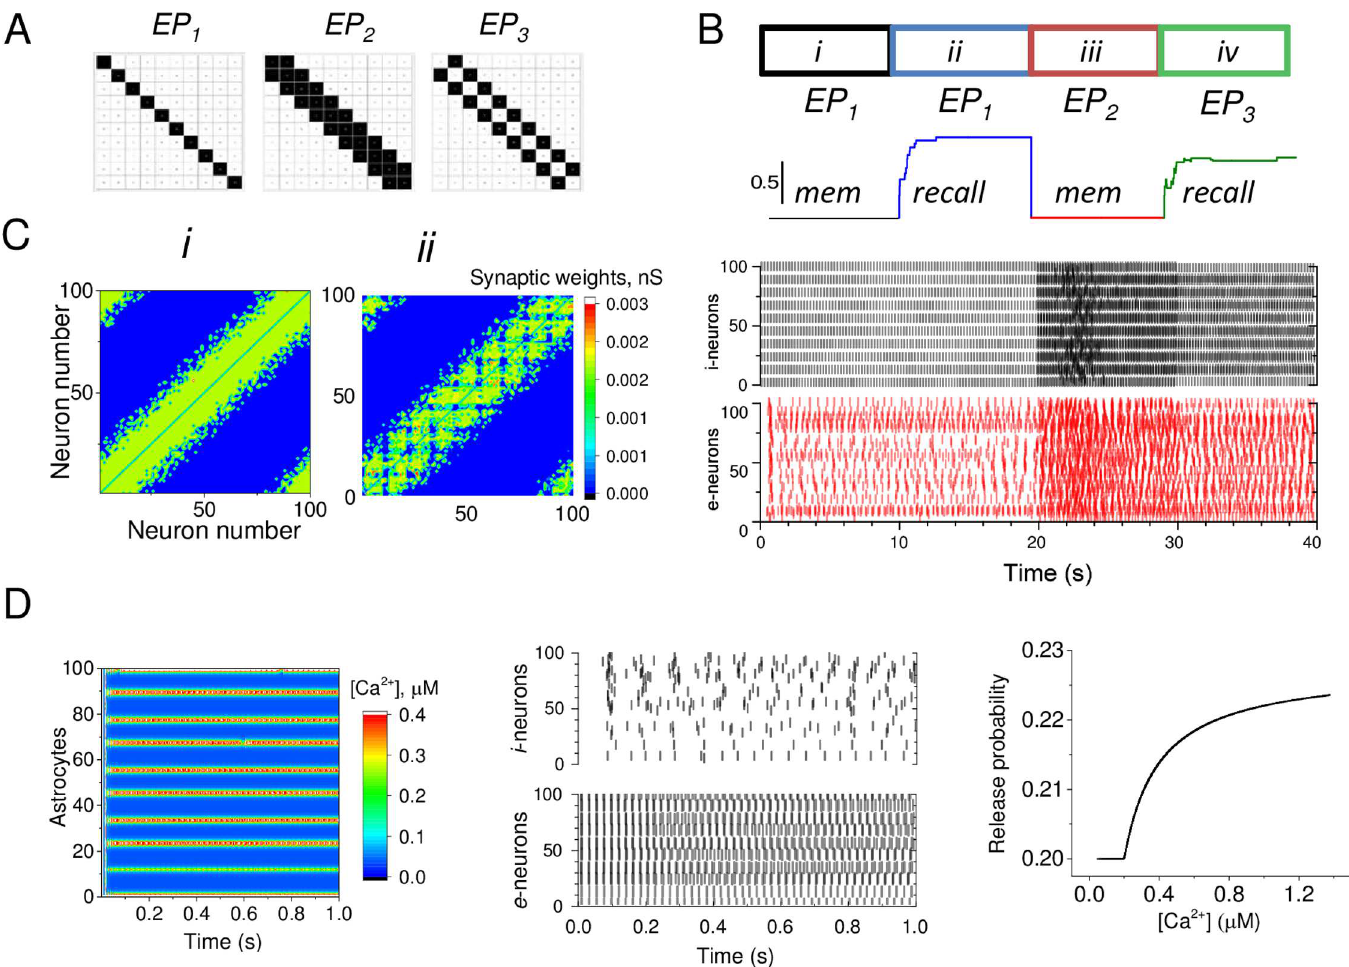
Fig 4. Exploring network memorisation, recall, and the effects of astroglial signalling. (A) External input patterns (EPs) used in simulations, as indicated. (B) Top , four successivenetwork stages ( i-iv ) of memorisation and recall, and the correspondingEPs, as indicated. Middle trace , dynamics of the recall quality(colours depict network stages). Bottom , spikingraster plots depictingthe overall dynamics of e- and i -networks correspondingto the four stages as above. (C) Exampleof the ee synapticconnections matrixes corresponding to the end of stages i and ii , as shown in (B). In simulations shown in (A-C) astrocytes are switched off. (D) Left , Color-coded time map of astrocyte calcium dynamics duringstage i shown in (B). Middle .Spiking raster plot of e - and i - networks that correspondsto the astrocyte calciumdynamics shown on the left. Right . The hypothetical relationship betweenthe ei -connectionsynaptic releasedprobabilityand the astrocyte calcium